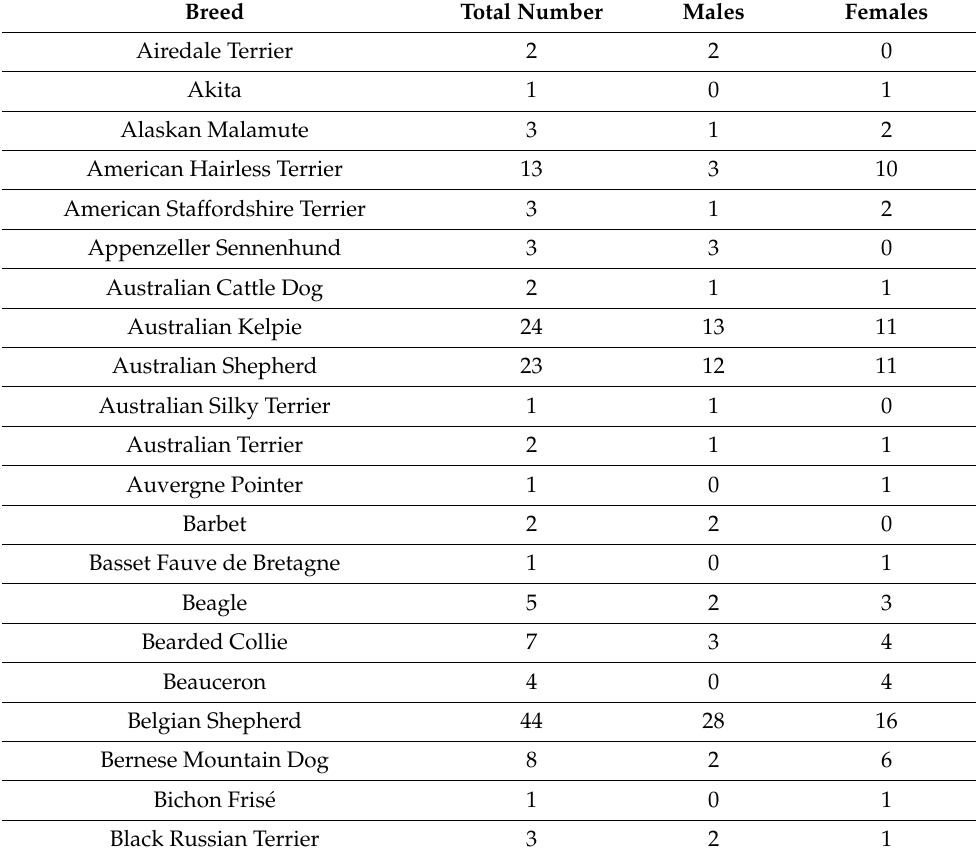
Table A1. Number of individuals from each breed included in the